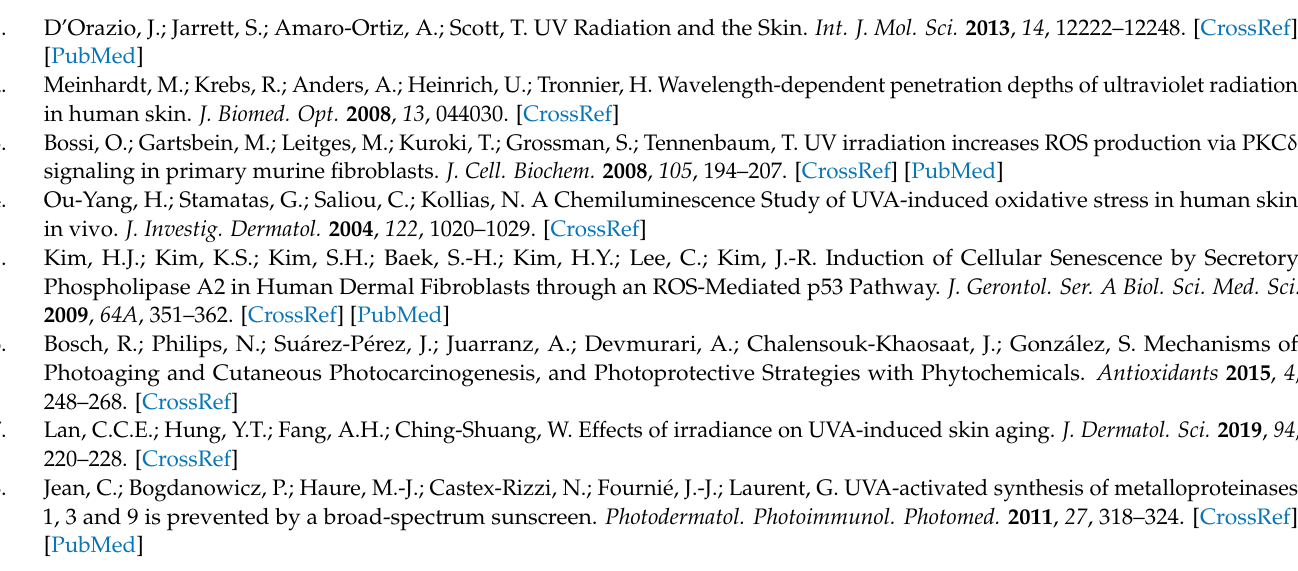
of reynosin, Figure S2: gHSQC (left) and gHMBC (right) spectra of reynosin, Figure S3: 1 H- 1 H COSY spectrum of santamarine, Figure S4: gHSQC (left) and gHMBC (right) spectra of santamarine, Figure S5: ( a ) 1 H-NMR spectrum of reynosin, ( b ) 13 C-NMR spectrum of reynosin, Figure S6: ( a ) 1 H-NMR spectrum of santamarine, ( b ) 13 C-NMR spectrum of